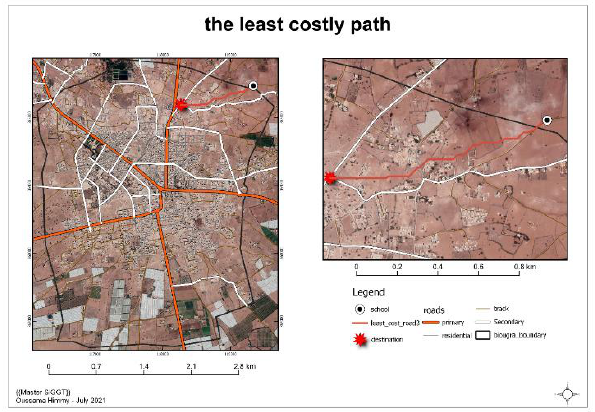
Figure 12 . Least costly access